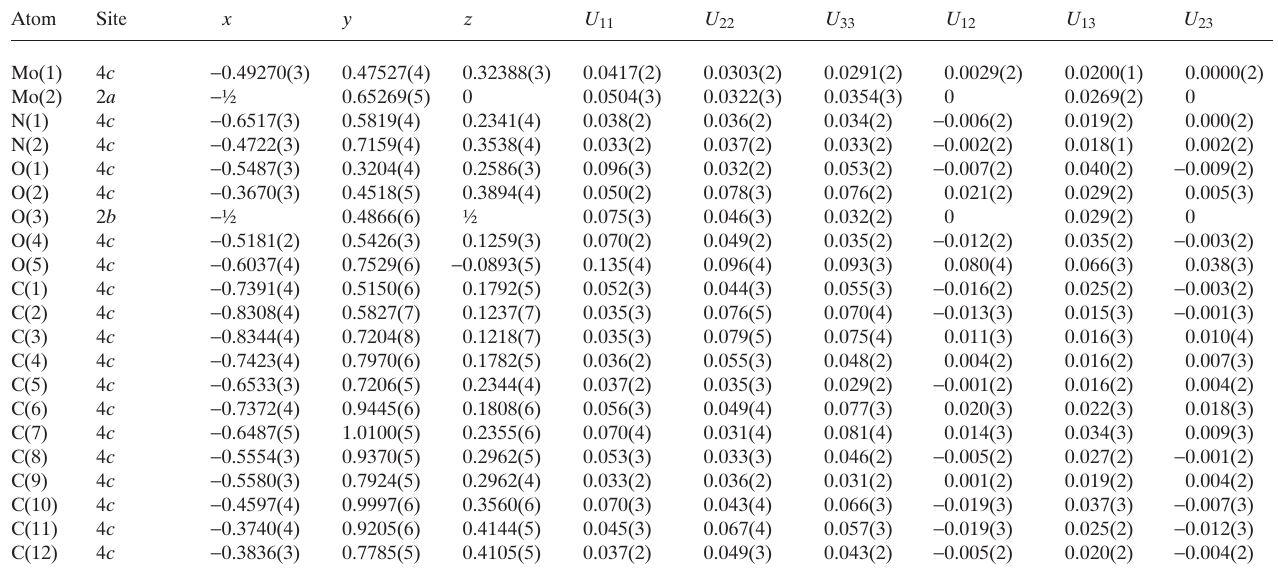
Table 3. Atomic coordinates and displacement parameters (in Å 2 ) .